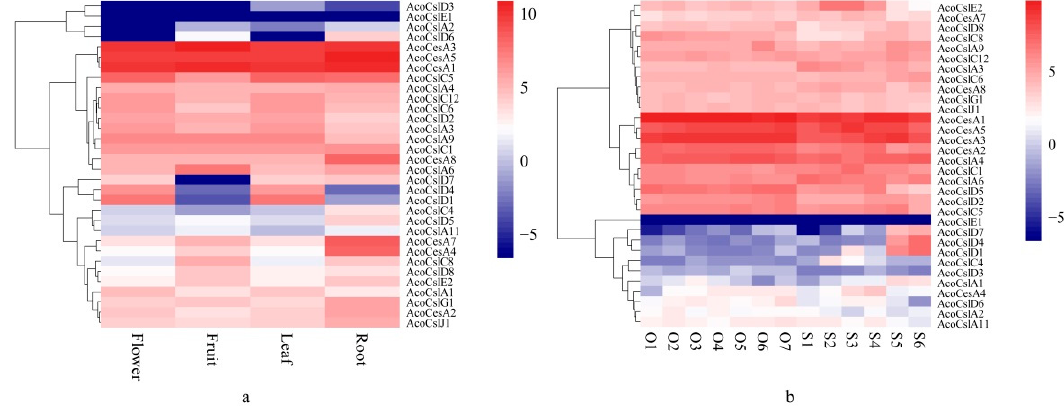
Figure 5. Organ-specific expression profiles of the pineapple AcoCes / Csl genes. ( a ) Expression profiles of AcoCes / Csl genes in flower, fruit, root and leaf of pineapple. ( b ) Expression patterns of AcoCes / Csl genes in developing ovule and stamen of pineapple. Hierarchical clustering of expression profiles of pineapple Ces / Csl genes in di ff erent organs and developmental stages. Red colors indicate high levels of transcript abundance, and blue colors indicate low transcript abundance. The color scale is shown at right side of the figure. Sample details are mentioned at the bottom of each lane: Ovule O1–O7, stamen S1–S6. The number after di ff erent tissues name refers to the di ff erent stage. Prefix ‘Aco’ indicates Ananas comosus .